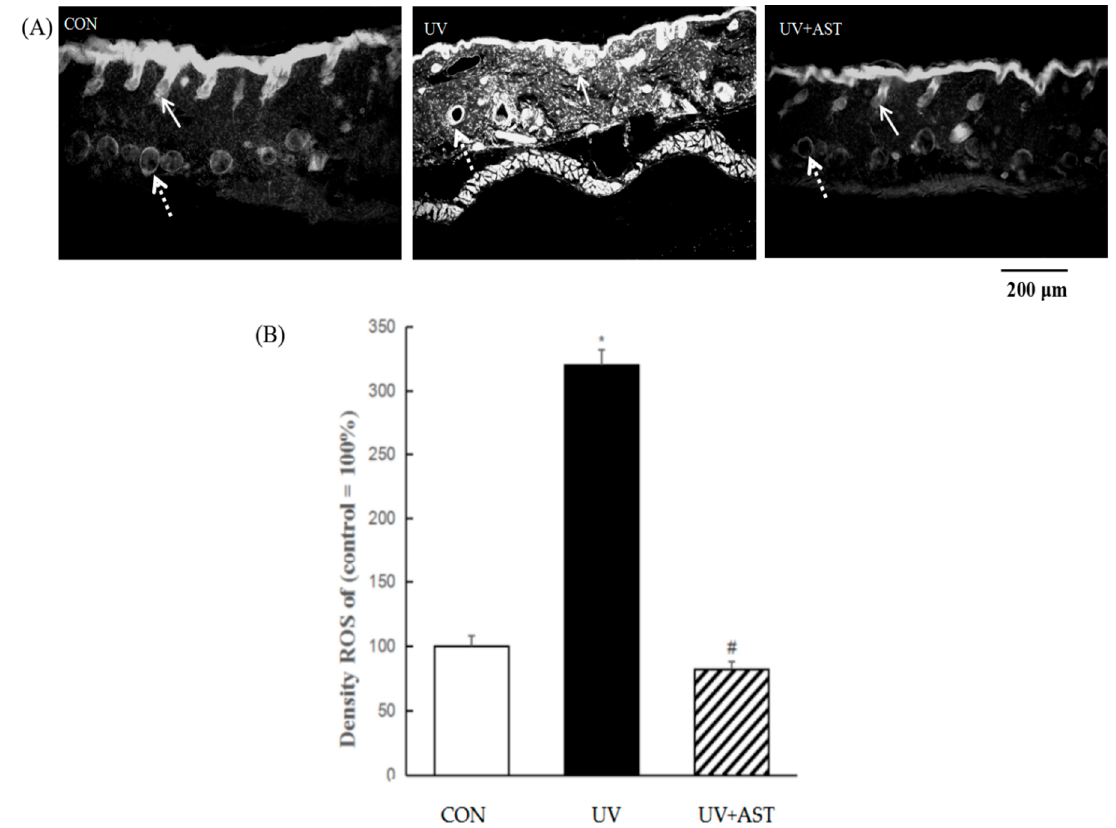
Figure 5. The effect of AST on ROS generation in the epidermis and capillary vessels in the dorsal skin of ultraviolet (UV)-induced mice. ( A ) Fluorescent staining. Scale bar = 200 µ m. Arrows indicate an ROS expression region (the solid arrows point to epidermis, the dotted lines point to cross-sections of capillaries). ( B ) Treatment with AST significantly suppressed the UV irradiation-induced increase in ROS in the dorsal skin of UV-induced mice. * p < 0.01 vs. control mice; # p < 0.01 vs. UV-induced mice.